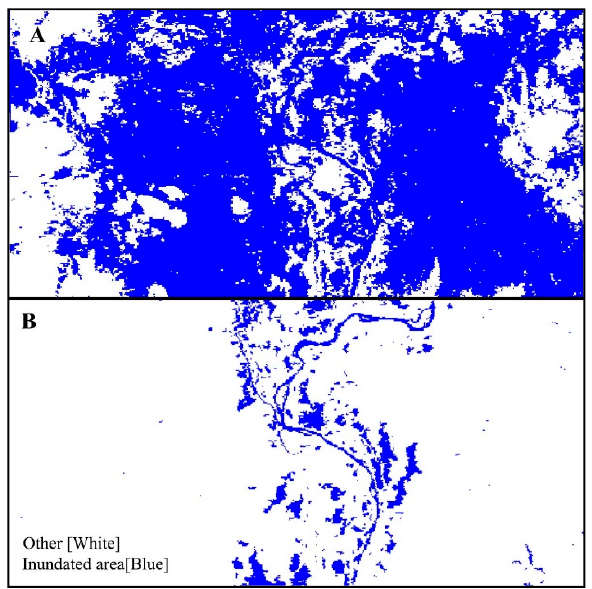
Figure 4. Inundated (water surface) area derived from ( A ) original WFFI and ( B ) modified WFFI on 1 January 2002. Table 1. Estimated accuracy of the WFFI product relative to the inundation area derived from Landsat images.